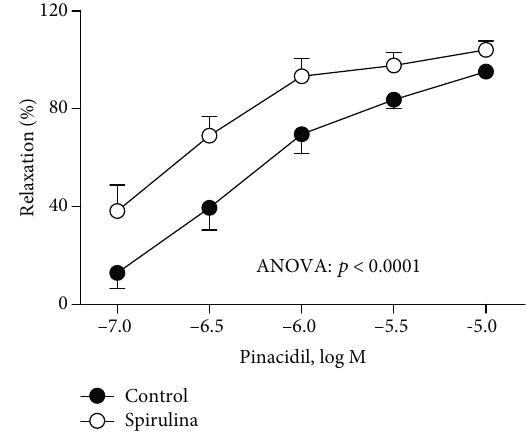
Figure 3: E ff ect of the aqueous Spirulina extract incubation on the concentration-response curve to the K channel opener ATP pinacidil in aortic segments from SHR. Results ( means ± SEM ) are represented as the percentage of inhibition of the contraction elicited by 0.1 μ M noradrenaline. Number of animals: 5-7. The statistical signi fi cance is indicated in the graph.